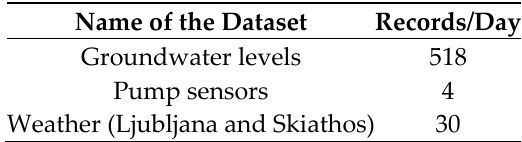
Table 2. Frequency of records per day for a single retriever